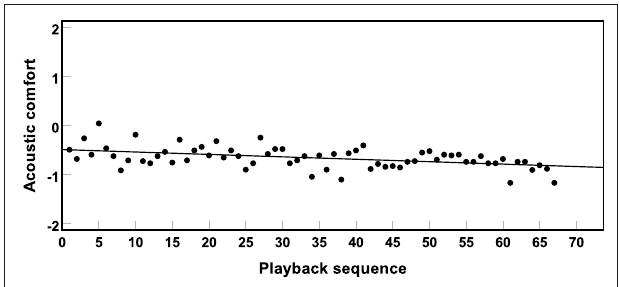
FIGURE 7 | Mean acoustic comfort ratings (for the combined data of the three experiments) across subjects and sound sources as a function of playback sequence. Notice that the second and the third experiments were conducted in one experimental session. Therefore, in the combined analysis, the playback number was registered from 1 to 67 (i.e., 40 and 27 stimuli in Experiments 2 and 3,